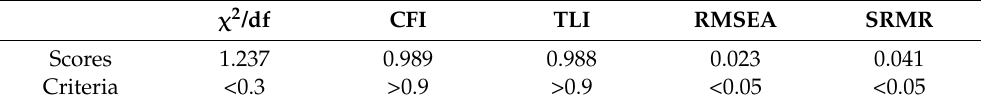
Table 2. Overall fit indices of the measurement